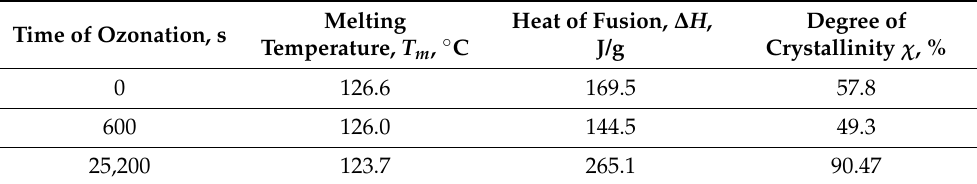
Table 2. Melting temperature, heat of fusion, and degree of crystallinity for ozonated MP HDPE membranes.